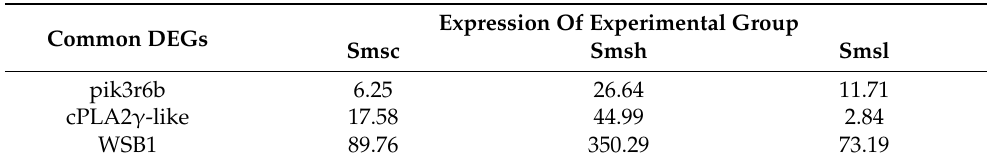
Figure 3. Venn diagram of differentially expressed genes. Table 4. The expression level of common genes in the transcriptome exposed to different salinity (FPKM).